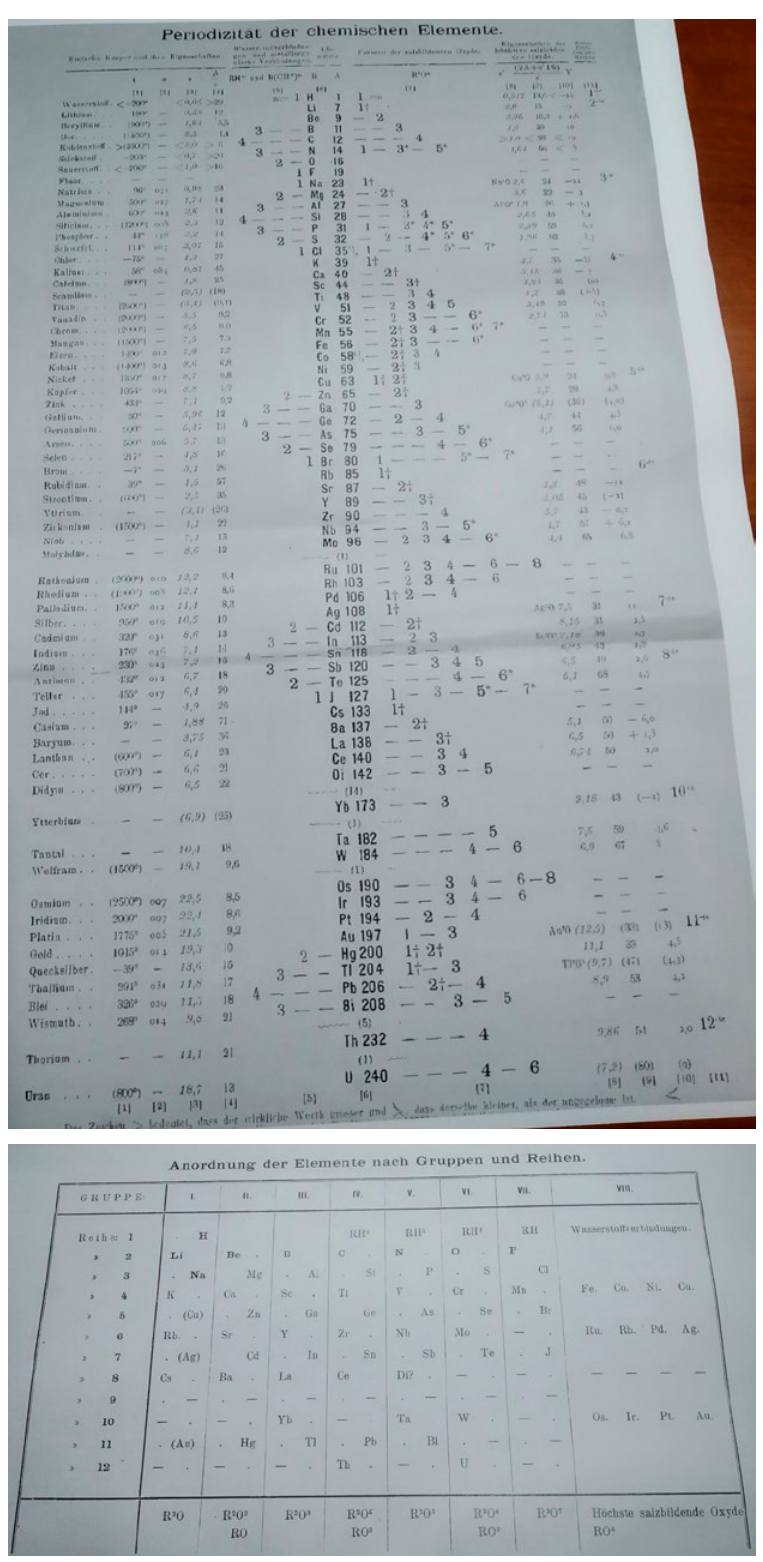
Figure 4. Tables inserted in D. Mendelejeff, Grundlagen der Chemie , 1891 (ref. 101, tables not